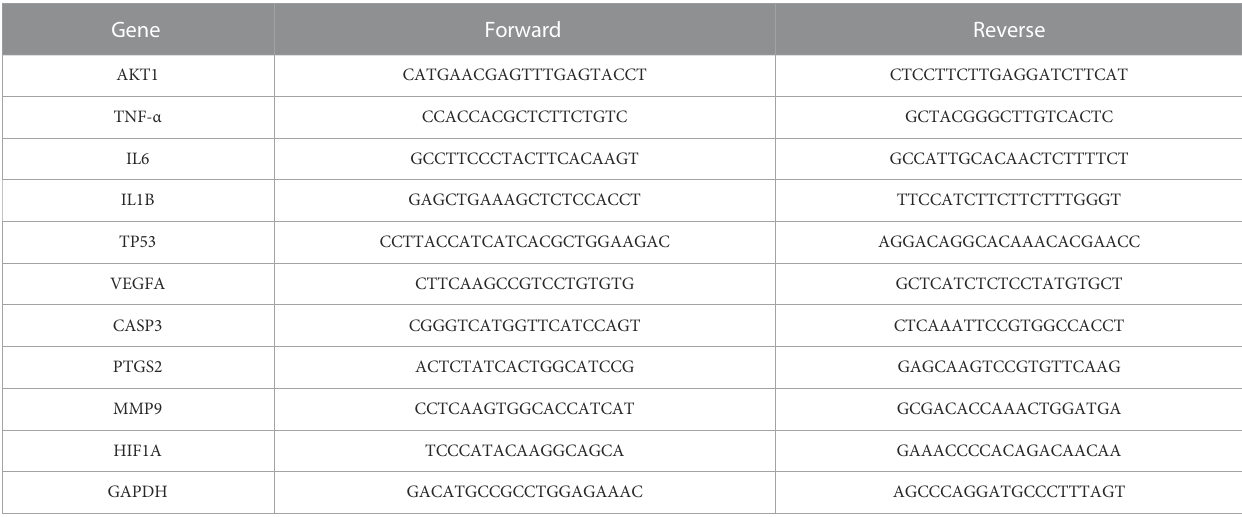
TABLE 1 Primer sequences.